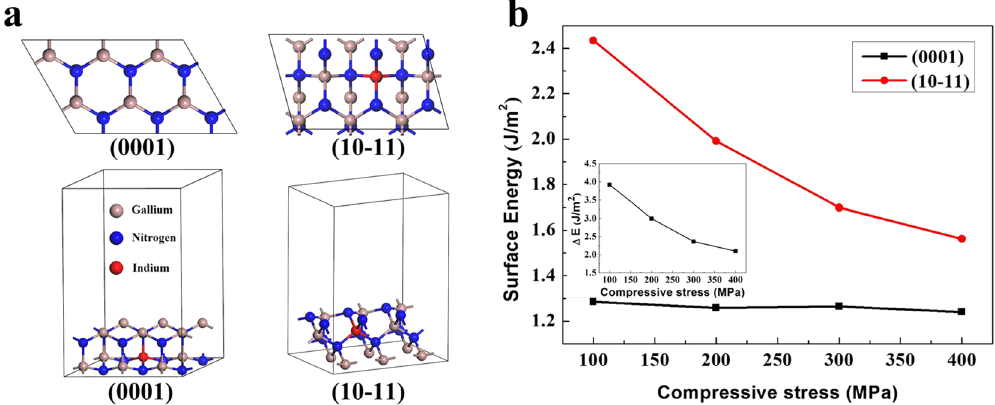
Figure 4. ( a ) Top and side views of the calculation model. ( b ) Surface energy of In-covered GaN(0001) and GaN(10–11) versus compressive